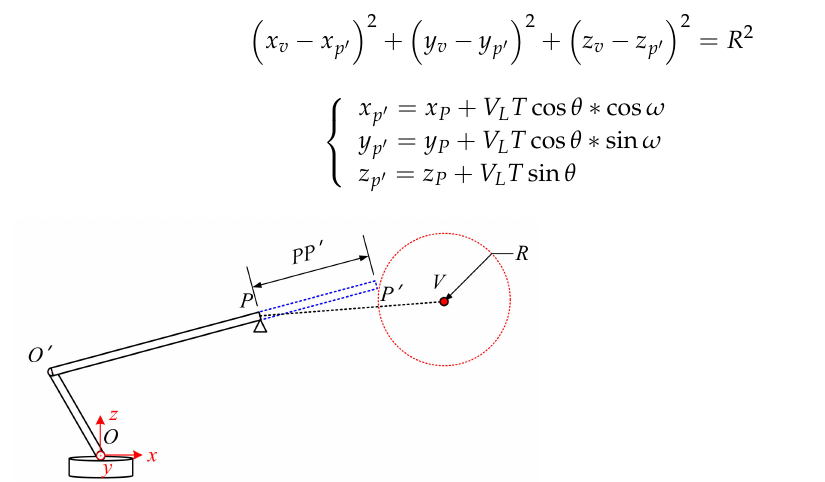
Figure 6. Collision urgency evaluation for